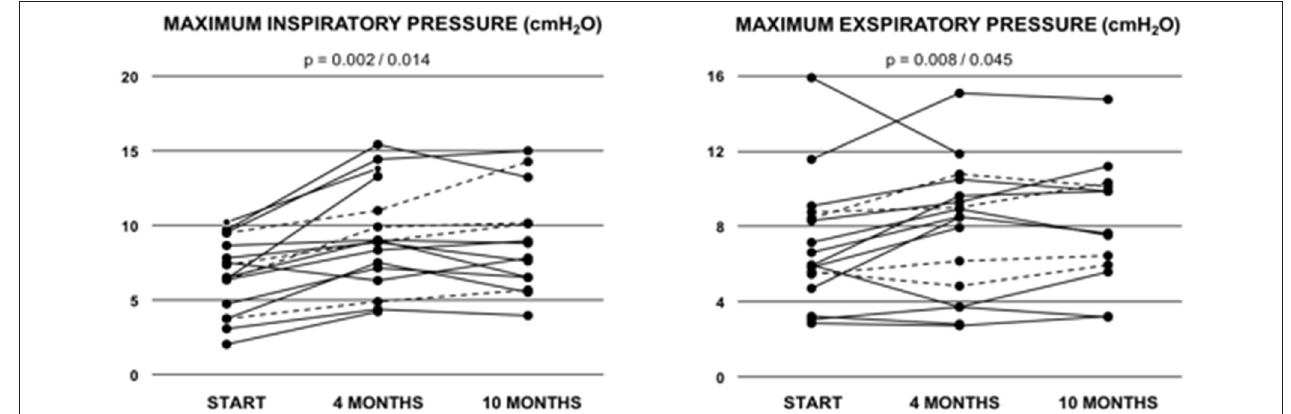
FIGURE 2 | Maximum inspiratory pressure (MIP) and maximum exspiratory pressure (MIP) in Fontan patients during the 10-months training period. Values are given at baseline (start), and after 4 and after 10 months of combined endurance and inspiratory muscle training. Each line represents one patient. Full lines represent teenage/adult patients, while dashed lines indicate patients who remained younger than 13 years throughout the study period. The first p -value refers to the total cohort of 18 patients, while the second p -value refers to the teenage/adult subgroup analyses only ( n =